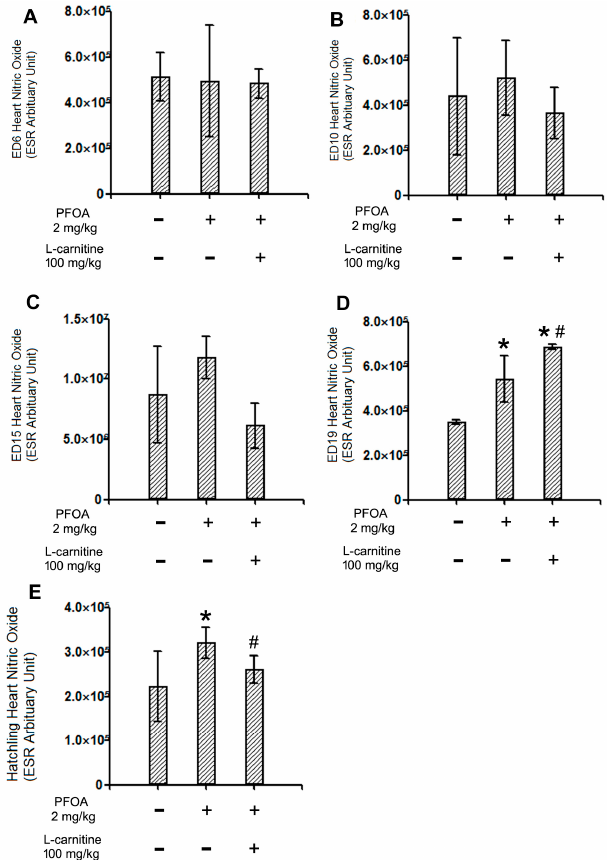
Figure 3. ESR results of the nitric oxide (NO) levels in ED6, 10, 15, and 19 chicken embryo hearts and